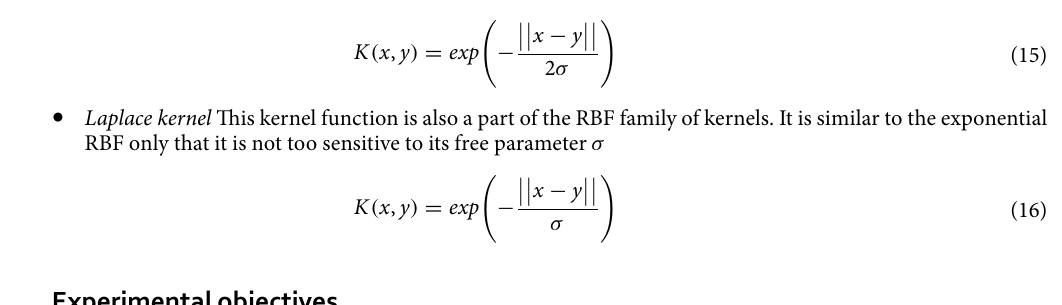
Figure 4. An illustration of the feature extraction process into Bag-of-Words and Binary features for 3 sample patient